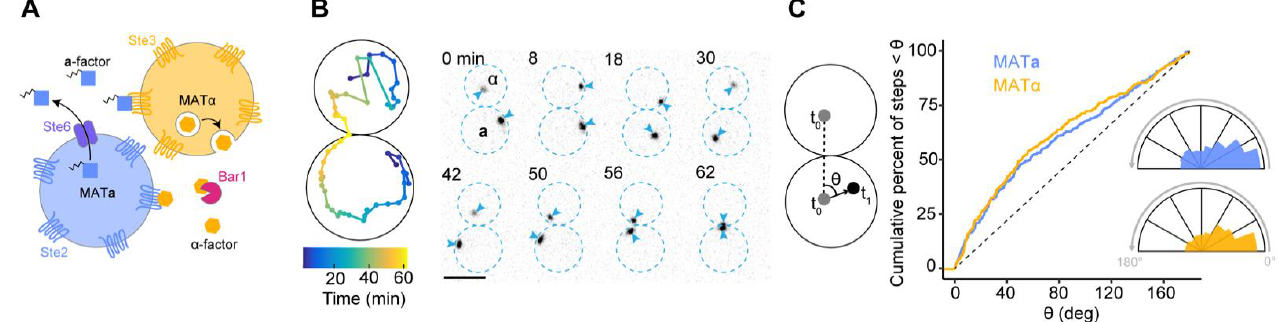
Figure 1. α -factor and a -factor provide similar spatial information. ( A ) Schematic illustrating the pheromones and receptors used by mating S. cerevisiae cells. MAT α cells secrete the unprenylated peptide α -factor by exocytosis, while MAT a cells secrete the prenylated peptide a -factor through the exporter Ste6. α -factor is detected by the receptor Ste2 on MAT a cells, while a -factor is detected by the receptor Ste3 on MAT α cells. α -factor is degraded by the protease Bar1 secreted by MAT a cells. ( B ) Polarity site movement during a mating event. Cells (DLY20626 and DLY20627) were treated with β -estradiol for 3 h to induce Ste5-CTM and then mixed and imaged. Inverted maximum projection images show polarity sites labeled by Spa2-mCherry (blue arrowheads). Dotted blue lines outline each cell. Time is in min. Scale bar, 5 µm. Left: Spa2 centroid trajectory (projected from 3D to 2D). ( C ) Angle of polarity site movement ( θ ) when partner sites are within 4 µm. θ is measured between the hypothetical optimum direction towards the partner’s polarity site (line between grey polarity site locations at the start of an imaging interval, t 0 ) and the direction of actual movement of the polarity site in the next step (2 min imaging interval: black polarity site, t 1 ). Cumulative distribution of angles measured at each step from MAT a (blue) and MAT α (yellow) cells ( n ≥ 296 steps). Inset: polar histogram of the same data. (Kolmogorov-Smirnov (KS) test = NS). Correct orientation of polarity requires reciprocal orientation of the partner’s polarity site: a cell cannot stably orient toward a partner that lacks a polarity site or has a mis-